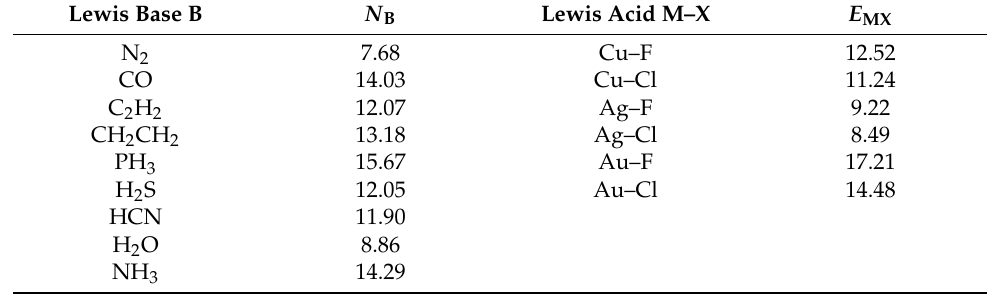
Table 4. Values of (a) the nucleophilicity N B of the Lewis bases and (b) the electrophilicities E MX of the Lewis acids M–X determined by fitting 54 D e values to Equation (2).